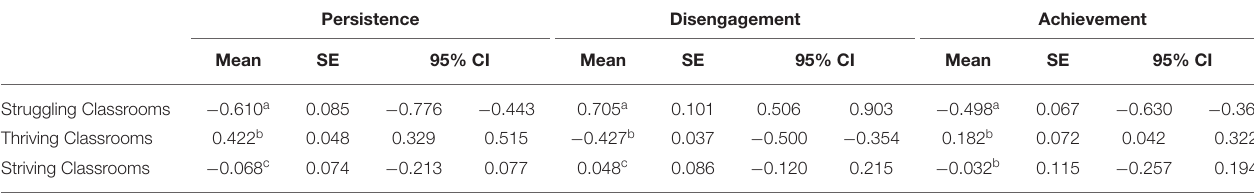
TABLE 5 | Means (and SEs and 95% CIs) on dependent variables for each instructional-psychological